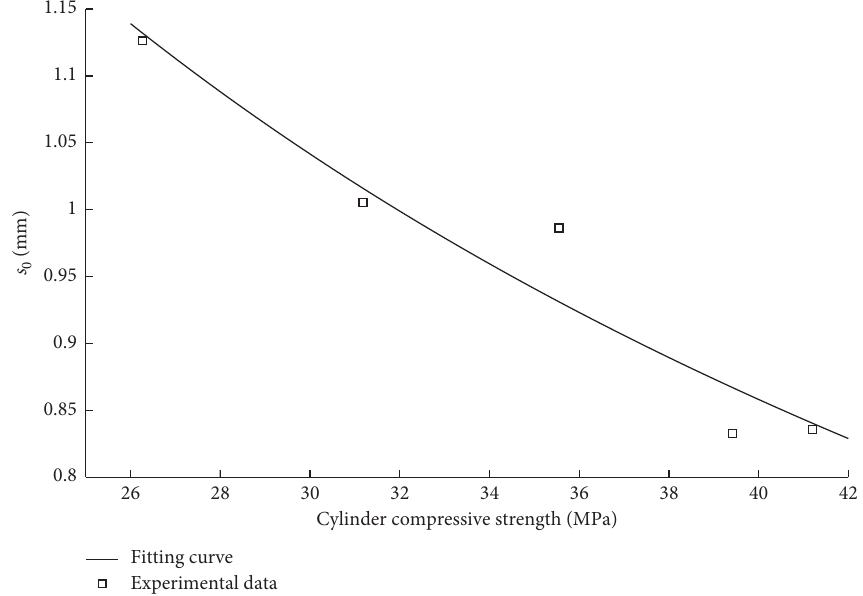
Figure 8: Relationship between slip at ultimate bond stress and cylinder compressive strength. Table 8: Theoretical and experimental results of slip at ultimate bond stress for HSC with various SAP